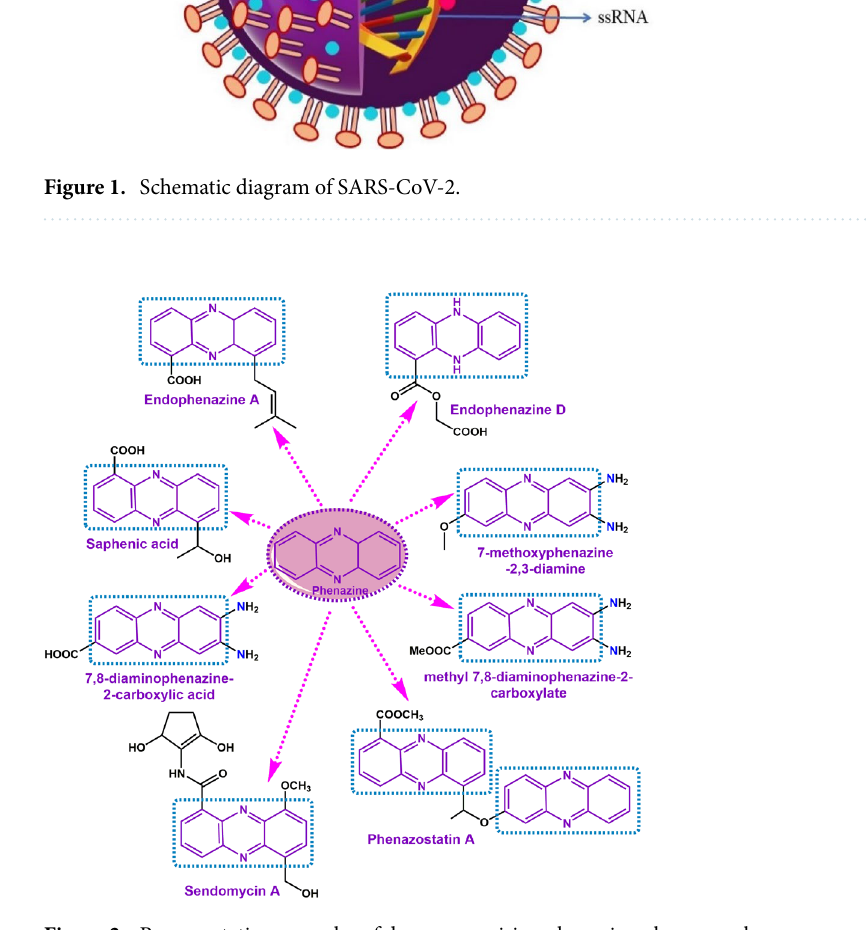
Figure 2. Representative examples of drugs comprising phenazine